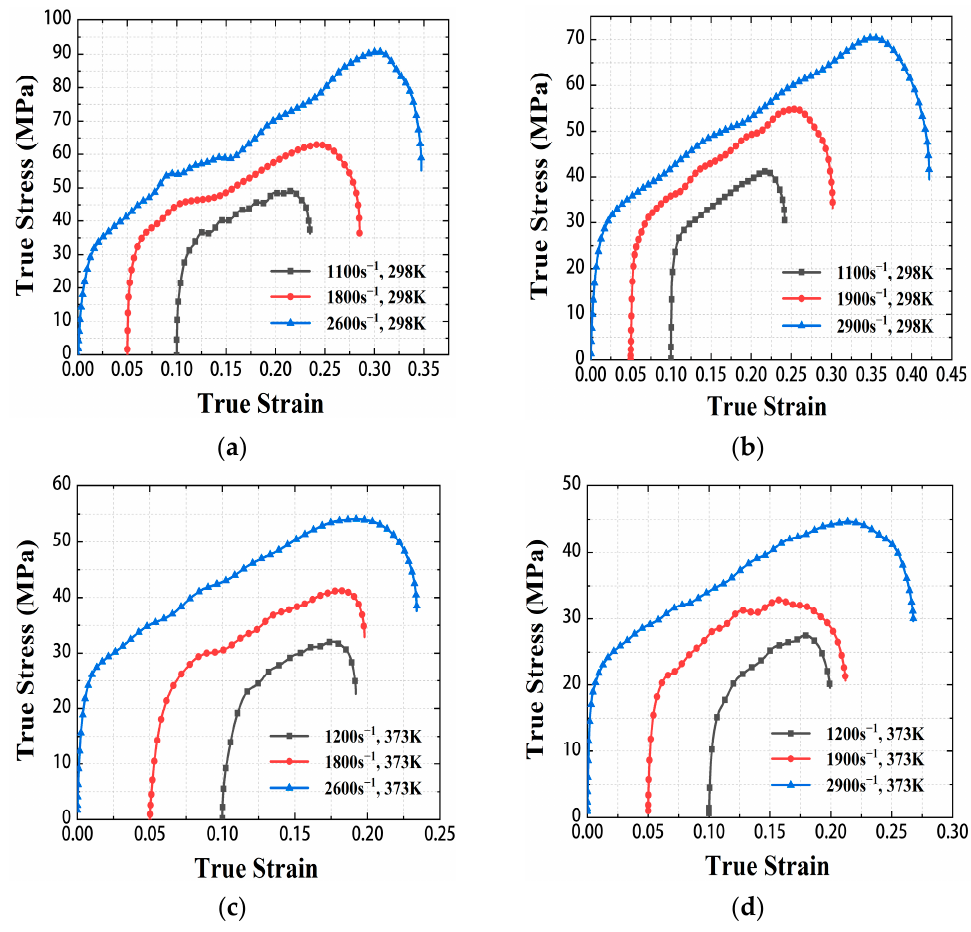
Figure 5. The stress-strain curves of Zr/PTFE, Ti/PTFE under dynamic loading. ( a ) Zr/PTFE, 298 K, ( b ) Ti/PTFE, 298 K, ( c ) Zr/PTFE, 373 K, ( d ) Ti/PTFE, 373 K. 90 ± 3 MPa at 1100 s − 1 , 1800 s − 1, and 2600 s − 1 strain rates under 298 K, respectively.